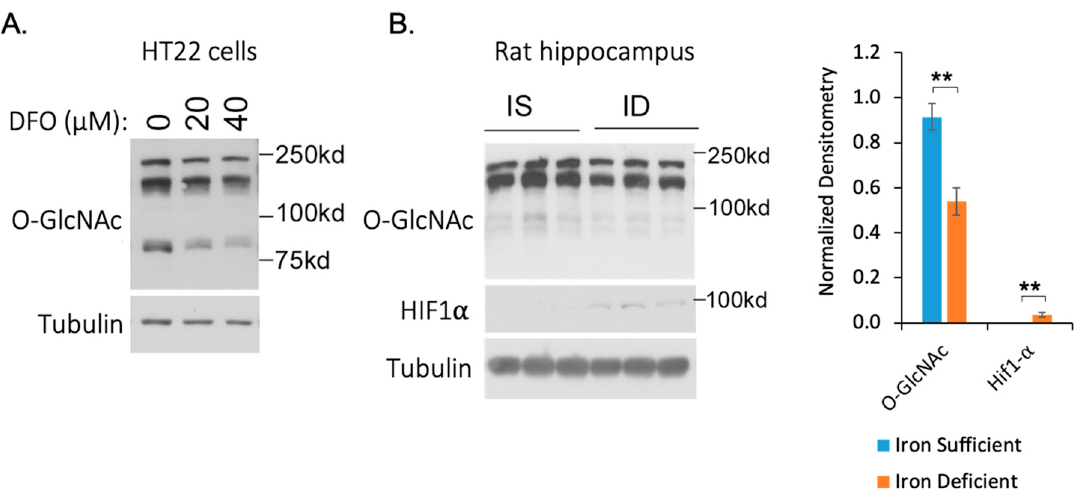
Figure 6. Iron deficiency decreases global O-GlcNAcylation. ( A ) Iron deficiency decreases the global O-GlcNAcylation level in HT22 cells in a dose-dependent manner. HT22 cells were treated with the indicated concentrations of DFO for 24 h and harvested for Western blotting. ( B ) Iron deficiency decreases global O-GlcNAcylation in the rat hippocampus. Iron-sufficient (IS) and iron-deficient (ID) hippocampal protein lysates were analyzed by Western blotting (WB) with the indicated antibodies. Global O-GlcNAc and HIF1a levels were quantified and normalized to tubulin. ** t -test, n = 3, p value < 0.01.